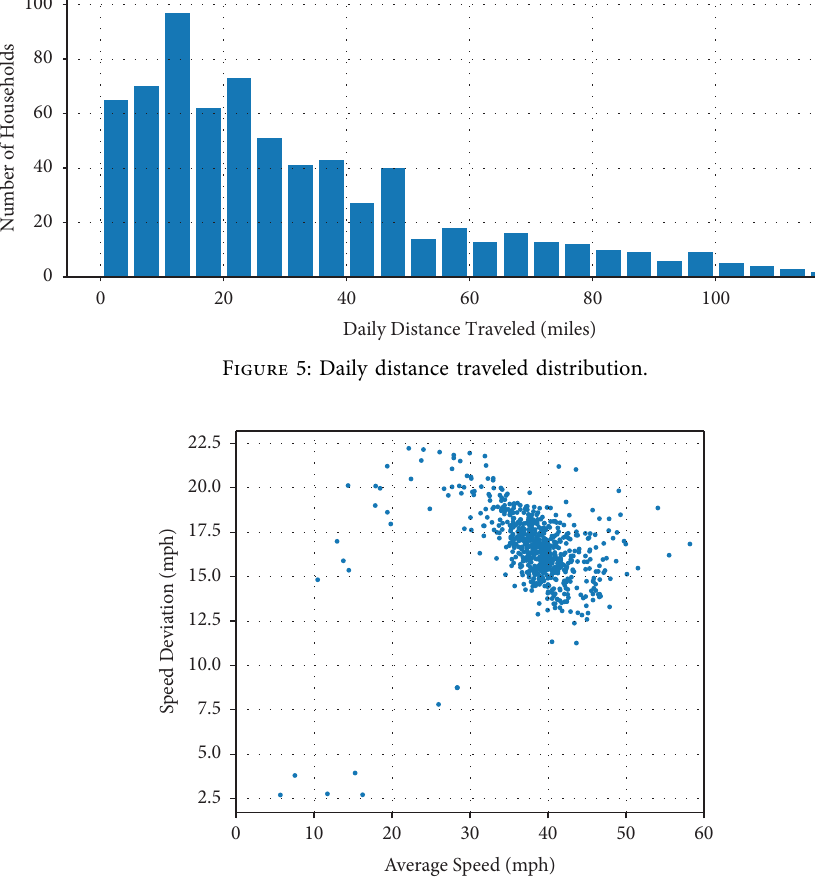
Figure 6: Speed deviation vs. average speed for combined daily drive cycles of